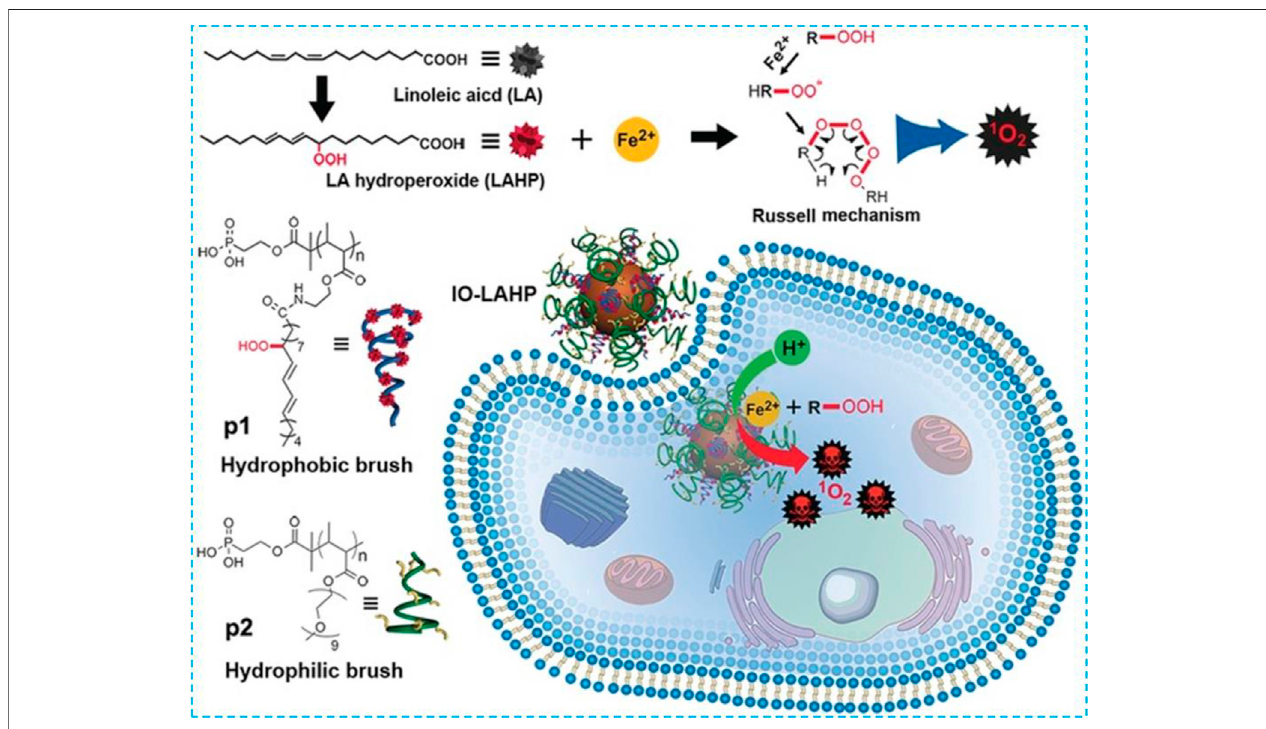
FIGURE7| Preparationandferroptosis-mediatedcancertherapyofIO-LAHP.ReprintedwithpermissionfromRef.(Zhouetal.,2017).Copyright2017Wiley-VCH.